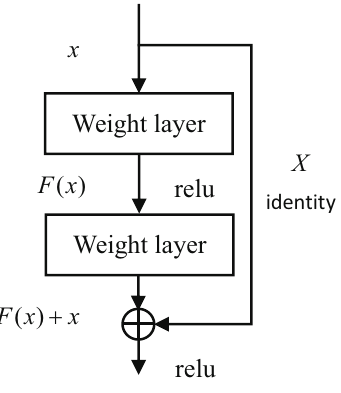
Figure 2. The shortcut connection. Table 1. The specific structure of ResNet-50 and